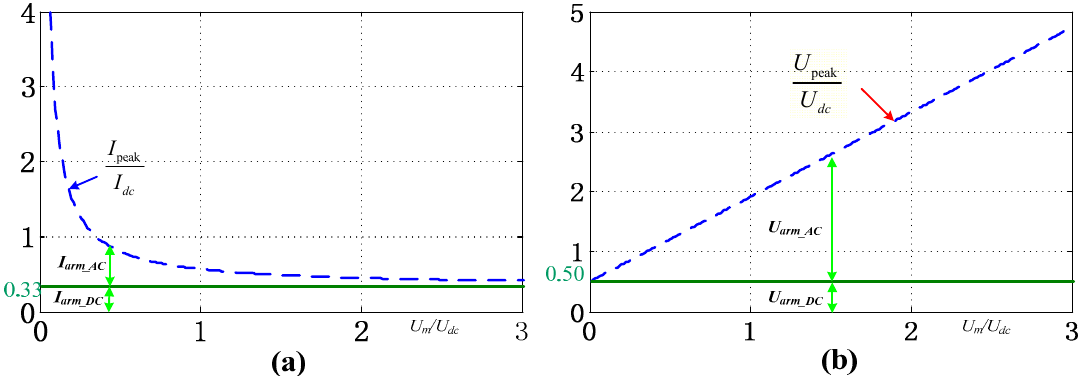
Figure 2. Influence of the AC side input voltage on the peaks of arm voltage and current ( a ) on the current ( b ) on arm voltage.